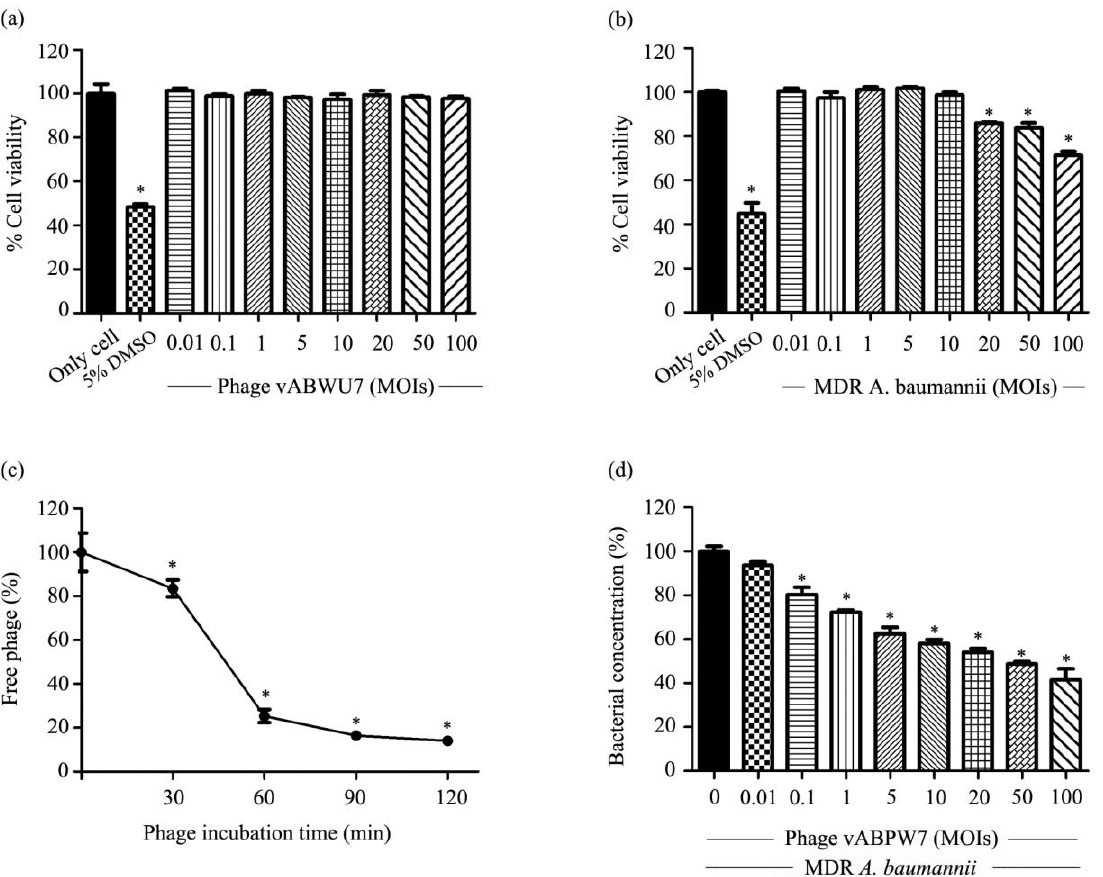
Figure 7. Efficacy of phage vABPW7 in A549 cell culture model. Cytotoxicity of phage